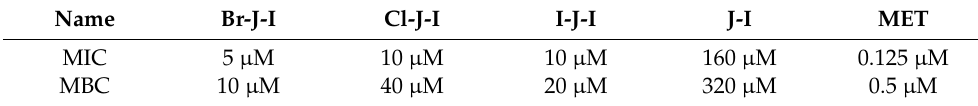
Table 2. MIC and MBC of peptides against Fn